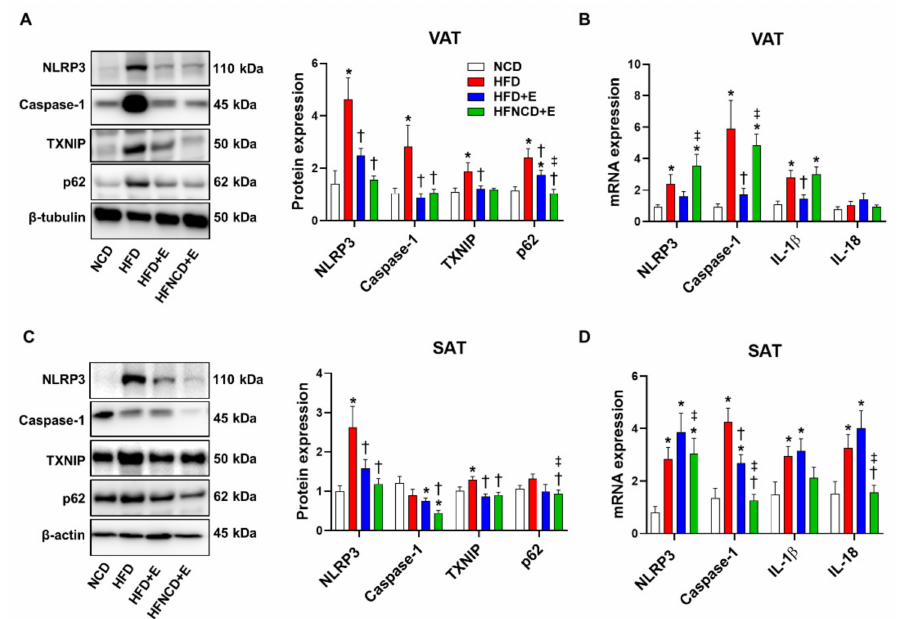
Figure 4. Exercise and diet attenuate HFD-induced NLRP3 inflammasome expression in adipose tissues. Representative Western blots and quantifications in VAT ( A ) and SAT ( C ) lysates, respec- tively. The quantifications were normalized to either β -tubulin (VAT) or β -actin (SAT) levels. Gene expressions were measured using real-time PCR in VAT ( B ) and SAT ( D ). The quantifications were normalized to the 18S rRNA level for each target. Values are presented as mean ± SEM ( n = 8). * p < 0.05 compared with NCD, † p < 0.05 compared with HFD, ‡ p < 0.05 compared with